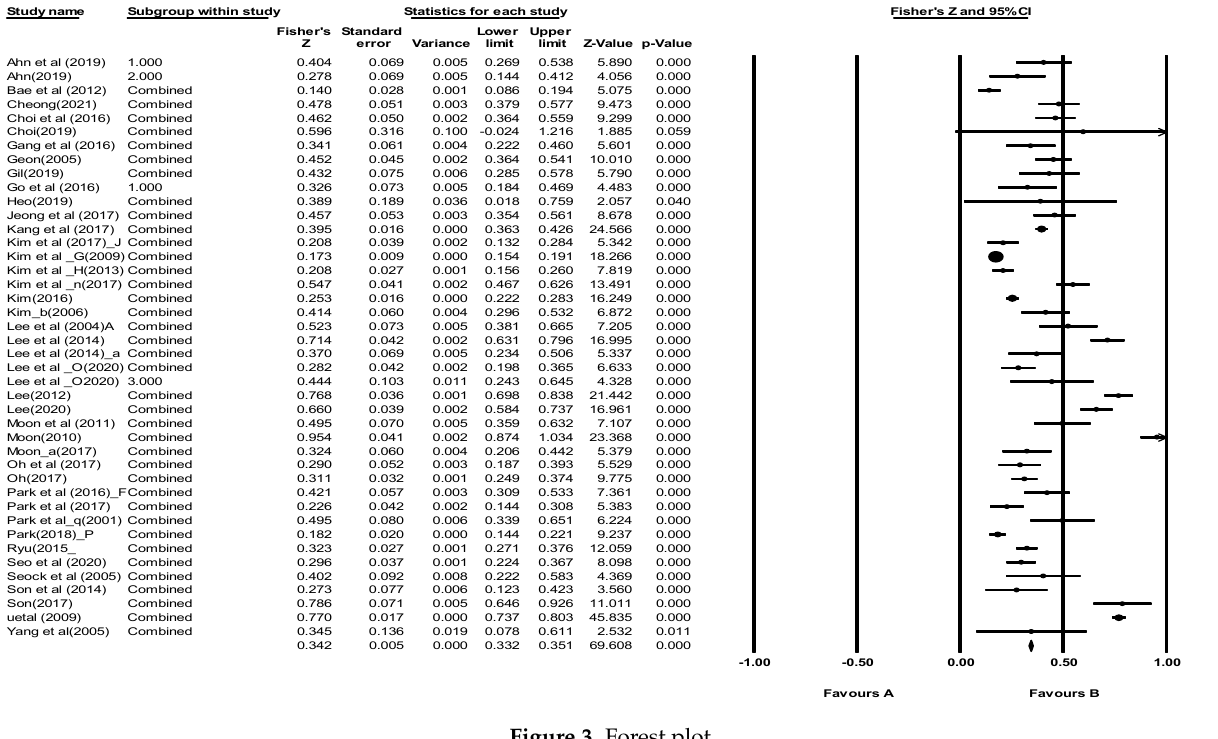
Figure 3. Forest plot. Table 4. Effect size of each structural factor related to stroke patients’ rehabilitation